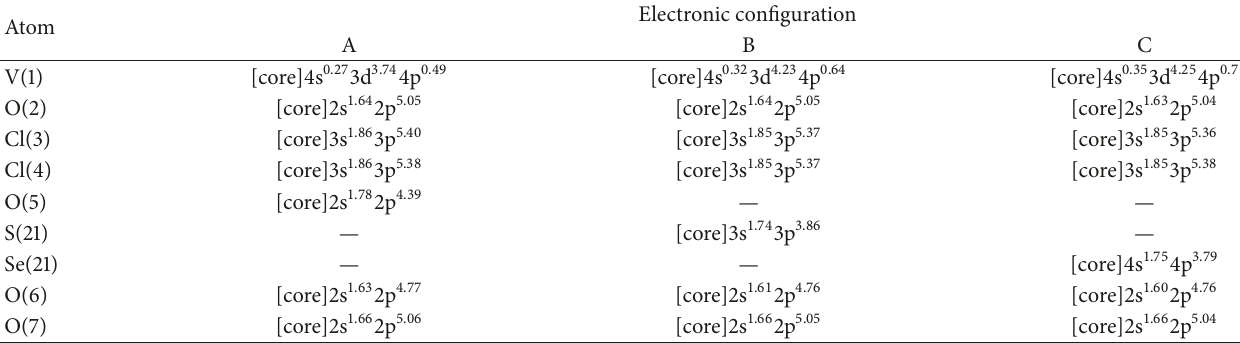
Table 2: Electronic configuration of selected atoms.